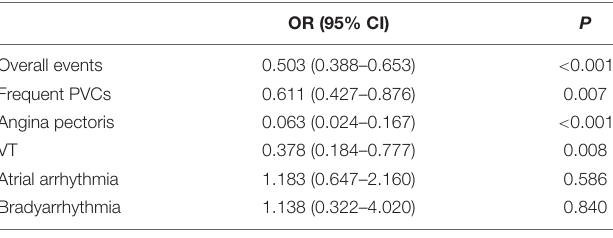
TABLE 3 | Correlation analysis between the occurrence of CV events and treadmill exercise in all subjects using the logistic regression analysis.